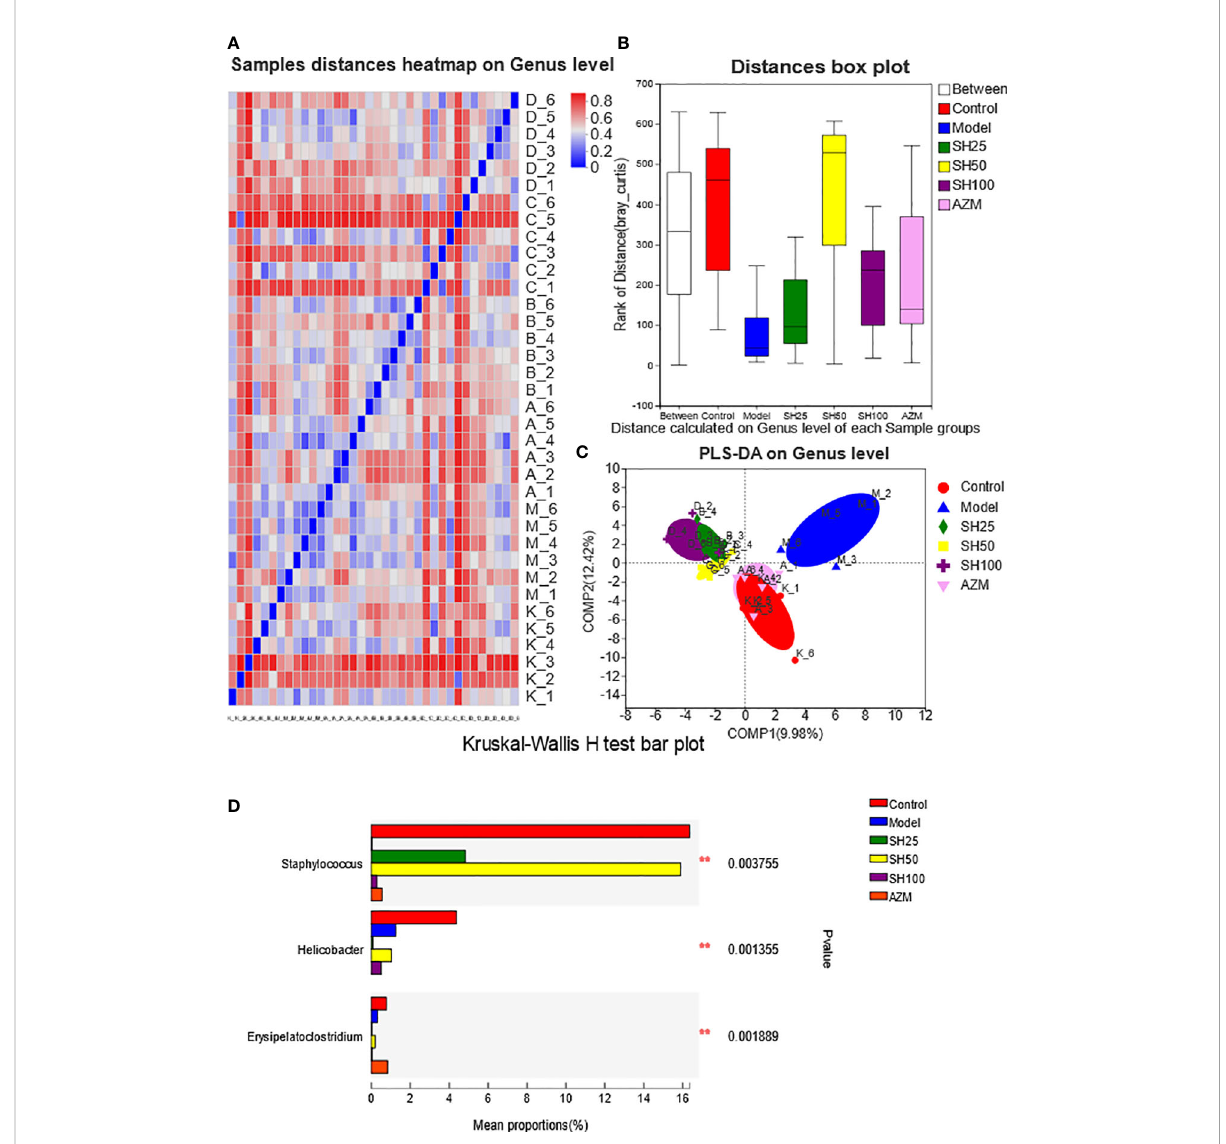
FIGURE 7 Analysis of comparison of gut micro fl ora samples. (A) Sample distances heatmap on Genus level: The X and Y axes are samples, and the distance between samples is represented by different color gradients (the right side of the fi gure is the value represented by the color gradient). (B) Bray_Curtis analysis of similarities: The X axe represents the distance value within or Between groups, The Y axe represents the distance value, the box corresponding to Between represents the distance value Between groups, and the other boxes represent the distance value within the group, to analyze the explanation degree of different grouping factors for sample differences. (C) Partial least-squares discriminant analysis: Dots of different colors or shapes represent sample populations in different environments or conditions. The scale of the X and Y axes is relative distance and has no practical signi fi cance. Comp1 and Comp2 represent the suspected in fl uencing factors of microbial composition bias of the two groups of samples, respectively. Kruskal-Wallis H-test bar plot analysis of differences in the abundance of intestinal fl ora species. (D) The vertical axis represents the species names at a taxonomic level. The column lengths corresponding to species indicate the average relative abundance of species in each sample group, and the different colors indicate the different groupings. **0.001<P ≤ 0.01. SH25, SH50 and SH100 mean SH 25 mg/kg, SH 50 mg/kg and SH 100